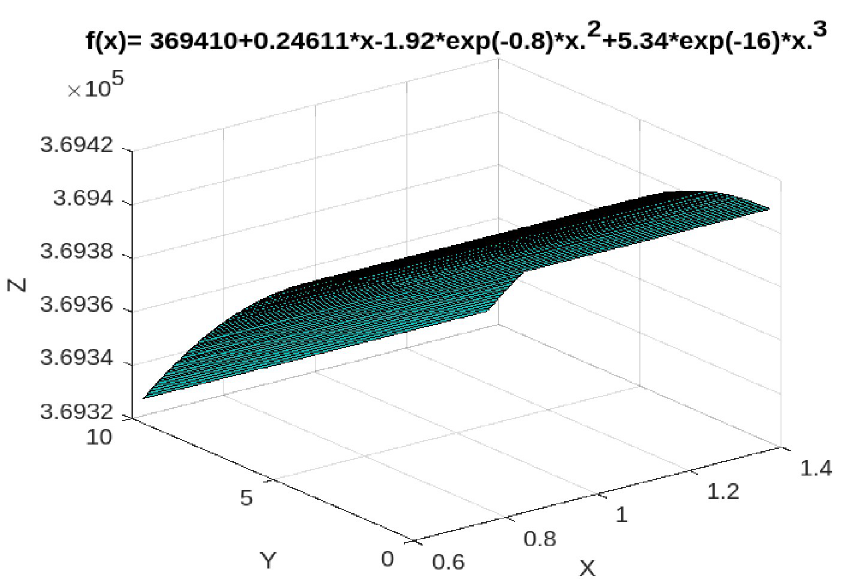
Fig 7. ITR-to-GDP threshold analyses, Taiwan,